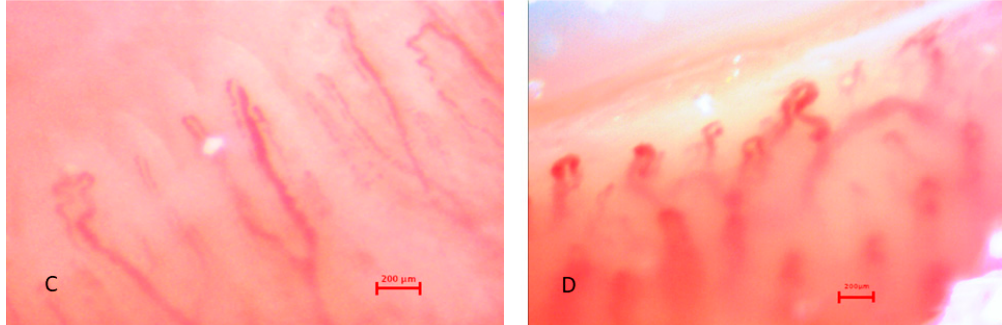
Figure 2. Capillaroscopic pictures of ( A ) tortuous capillaries, ( B ) meandering capillaries, giant capillaries, ( C ) spastic loops, aggregated flow, ( D ) irregular arrangement, giant capillaries, in the group with uRP.